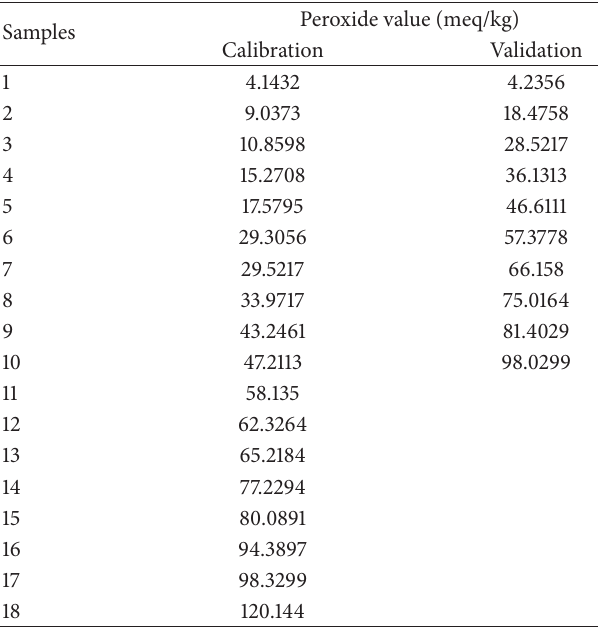
Table 1: The peroxide value (PV) of each sample used in both calibration and